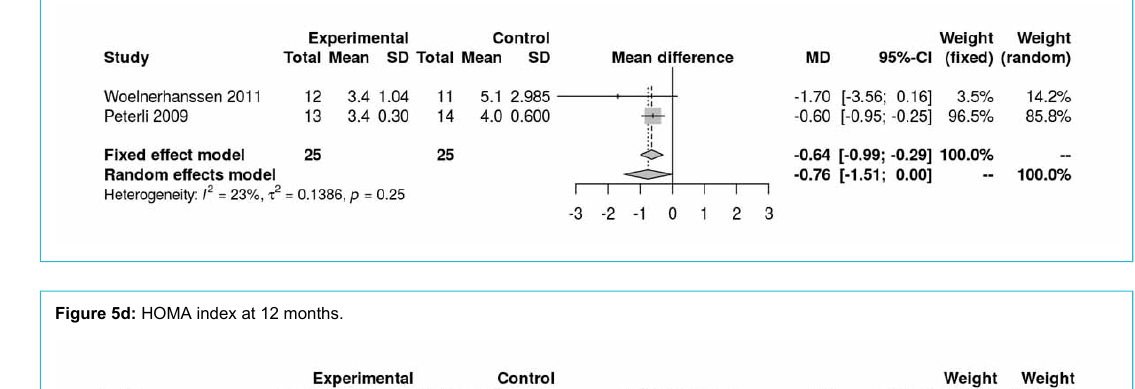
Figure 5d: HOMA index at 12 months.